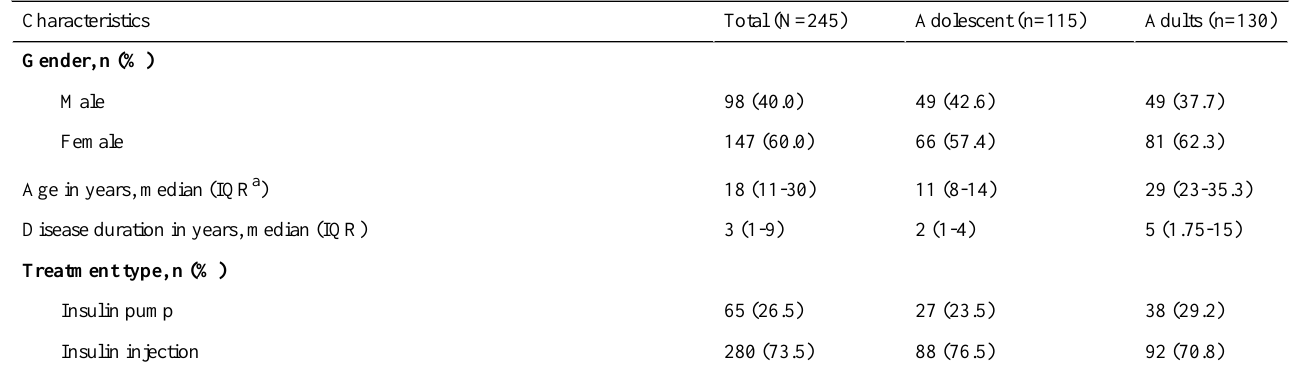
Table 1. Characteristics of patients responding to the